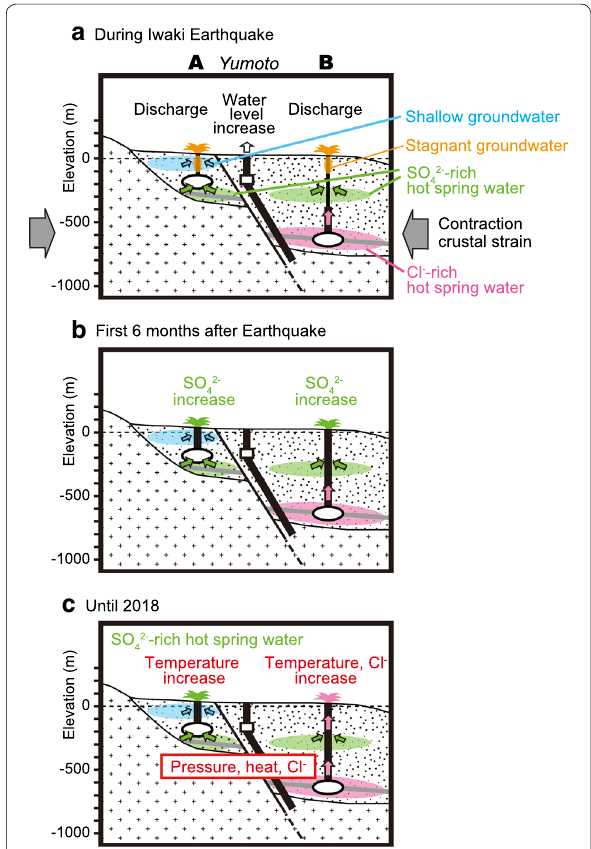
Fig. 6 Schematic diagrams showing changes in hot springs: a during the 2011 Iwaki earthquake, b first 6 months after earthquake and c until 2018. Geology, fault and underground structure correspond to Fig.